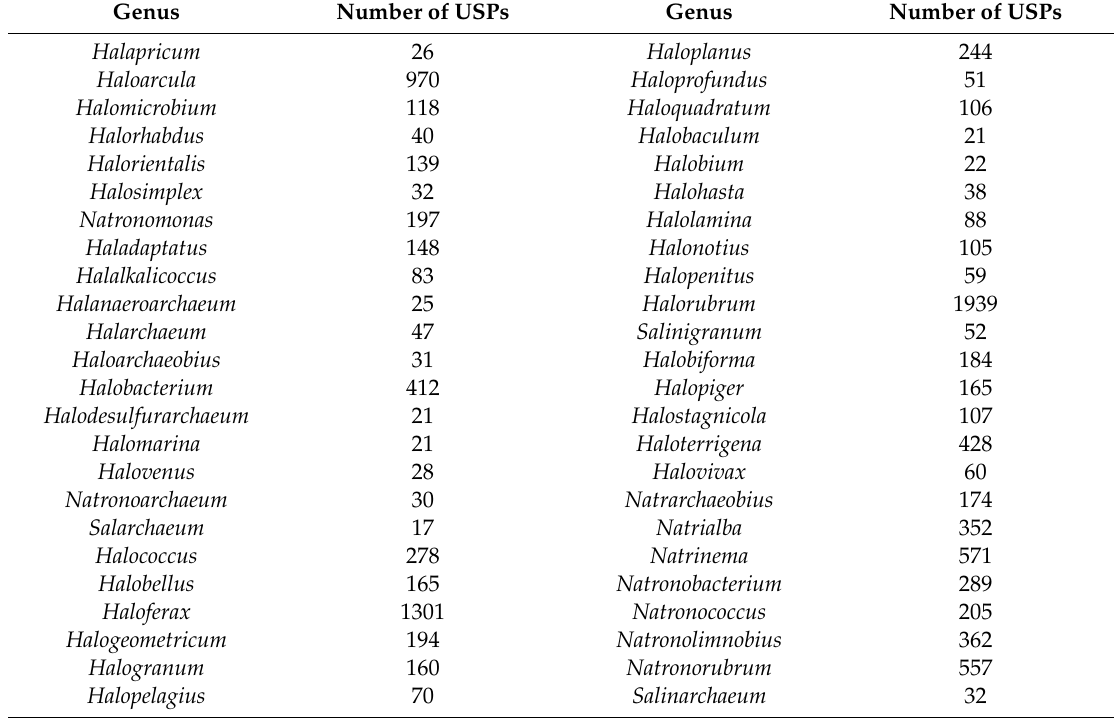
Table 5. Number of Universal Stress Proteins (USPs) found in halophilic archaea *.